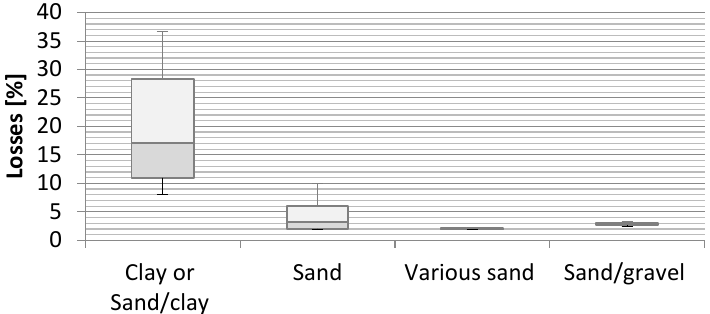
Figure 9. Total loss of drilling fluid in specific fractions.